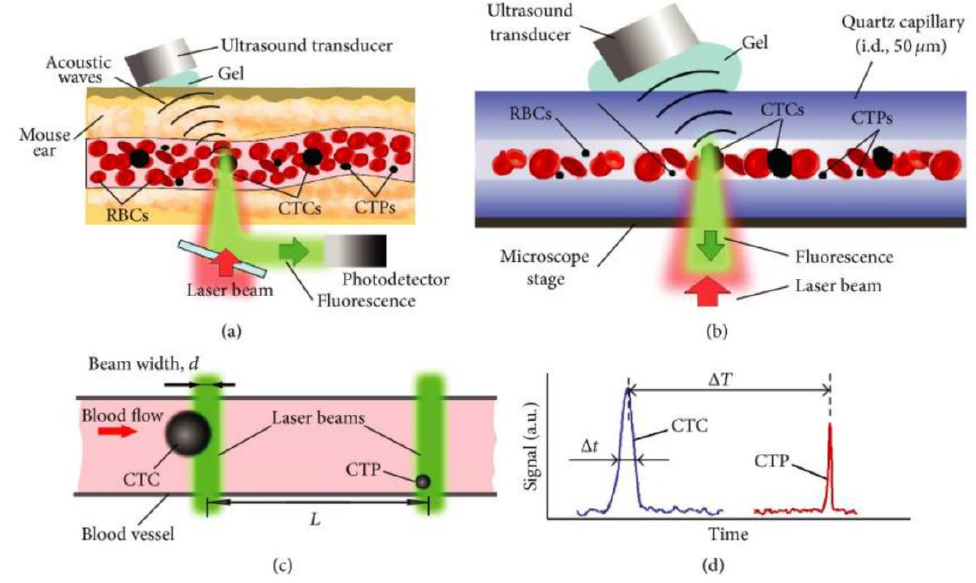
Figure 7. Photoacoustic and fluorescent flow cytometry platform [127]. (a) The principle of in vivo detection of CTCs and CTPs using integrated PAFFC schematic. (b) The in vitro schematic for detection of CTCs and CTPs in a capillary tube using PAFC. (c) Two-beam time-of-flight schematic. (d) Signal diagram for CTC and CTP identification in two-beam time-of-flight mode.